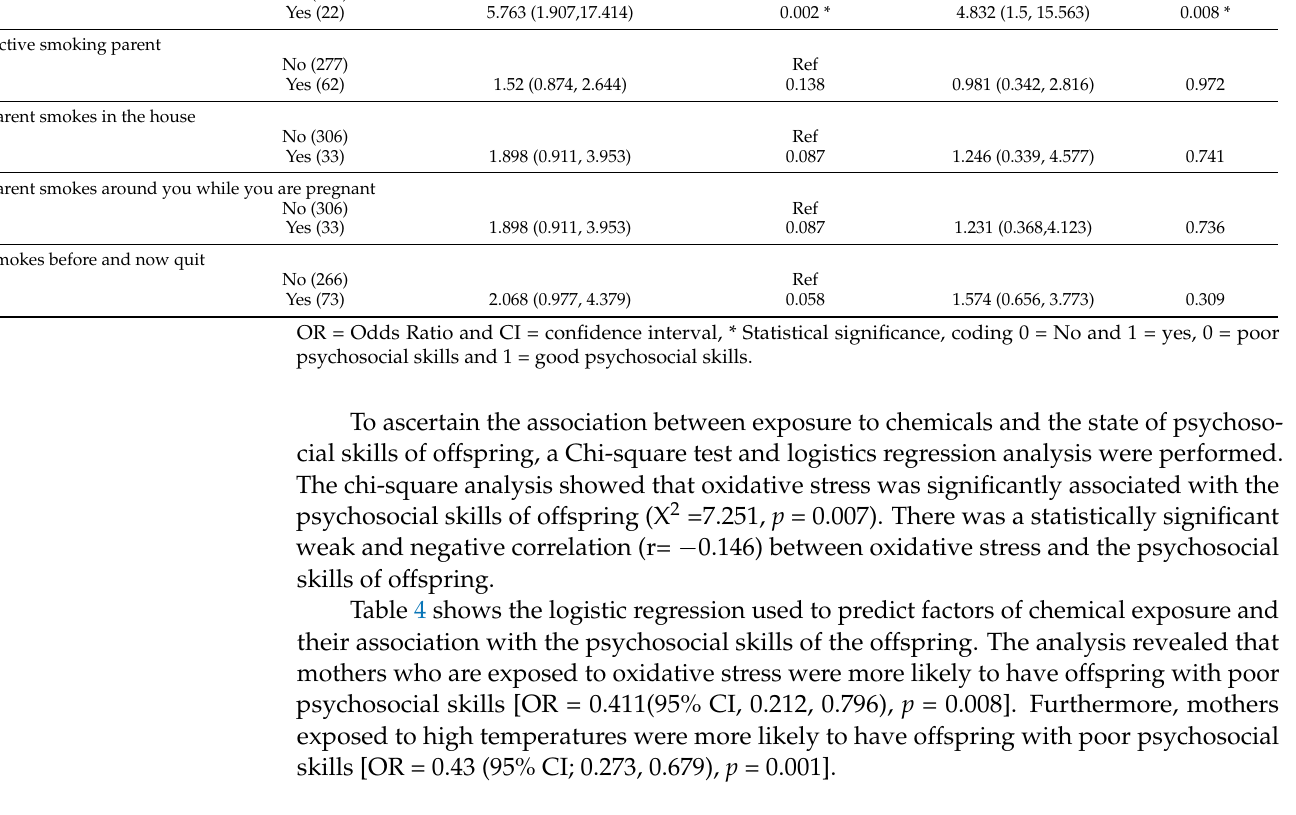
Table 4. Exposure to chemicals and psychosocial skills of